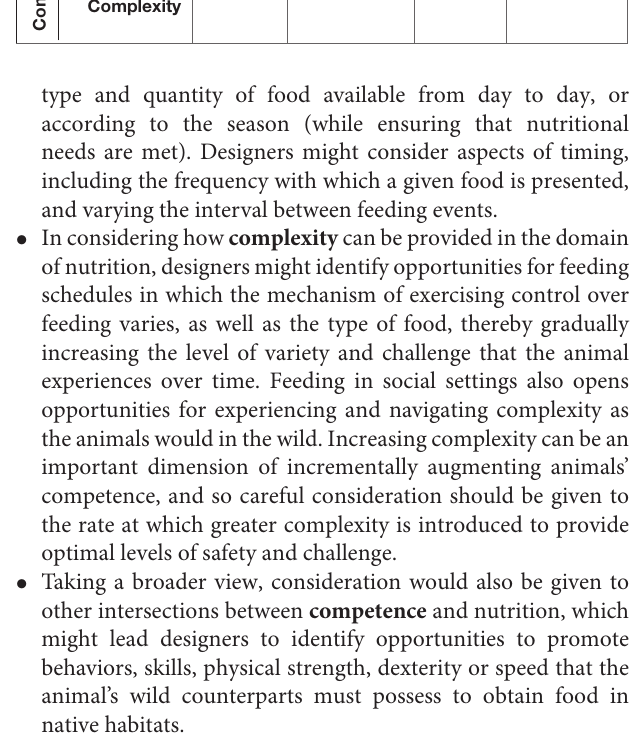
• Opportunities for variety in nutrition might be considered